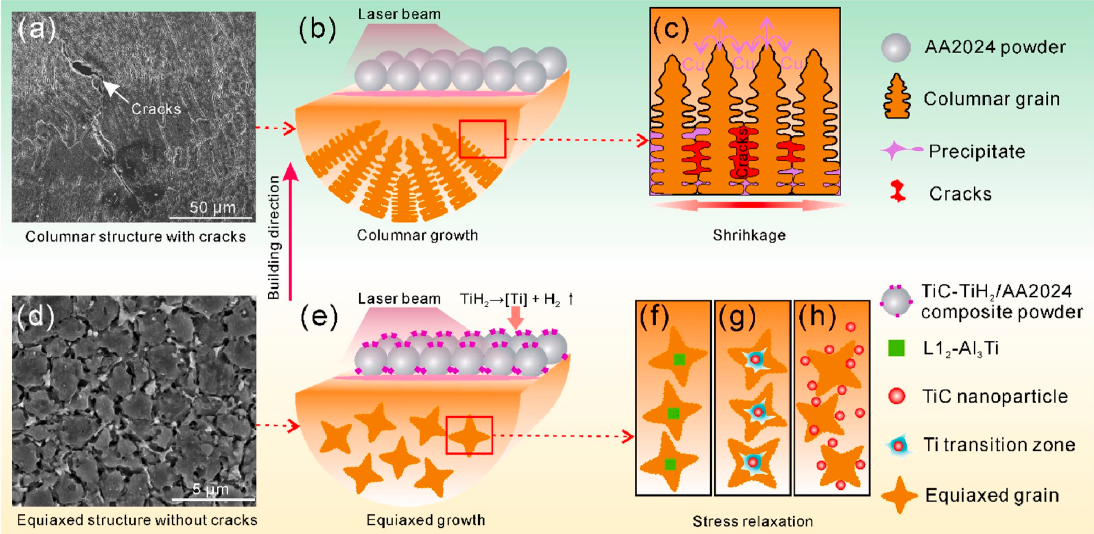
Figure 12. Schematic representation of microstructures and solidification mechanisms of LPBF- fabricated 2024 Al alloy ( a )–( c ) and 2024/TiC-TiH 2 composite ( d )–( h ) (reproduced with permission 2024 Al alloy ( a – c ) and 2024/TiC-TiH 2 composite ( d – h ) (reproduced with permission from [92]). from [92]).